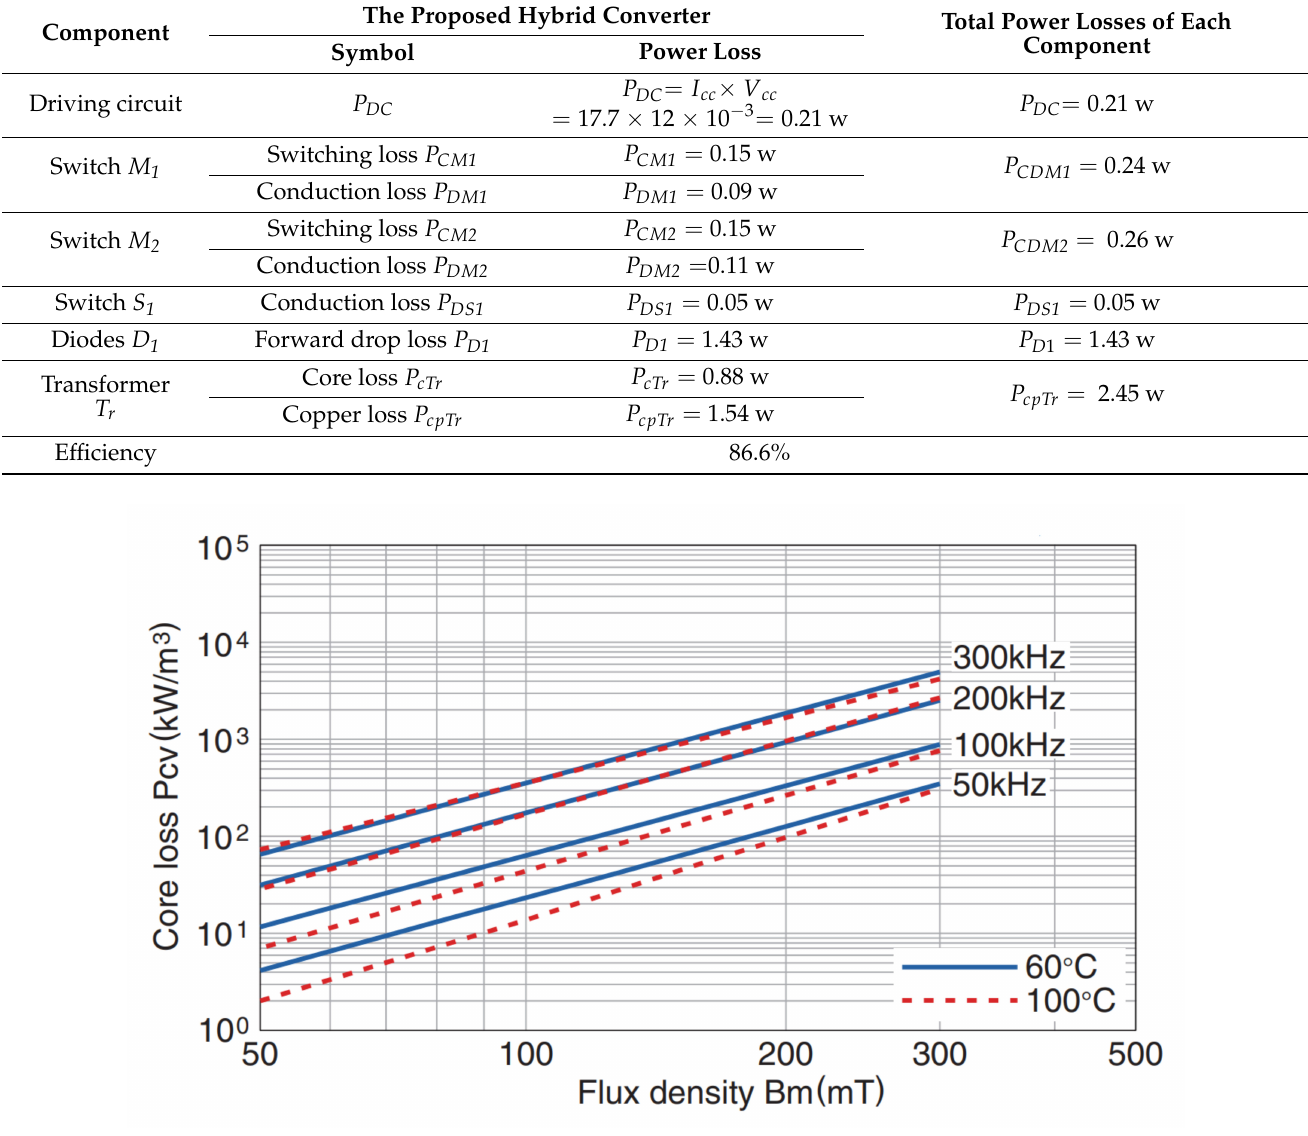
Figure 23. Core loss (mW/cm 3 ) curves of transformer T r manufactured by PC95 material of